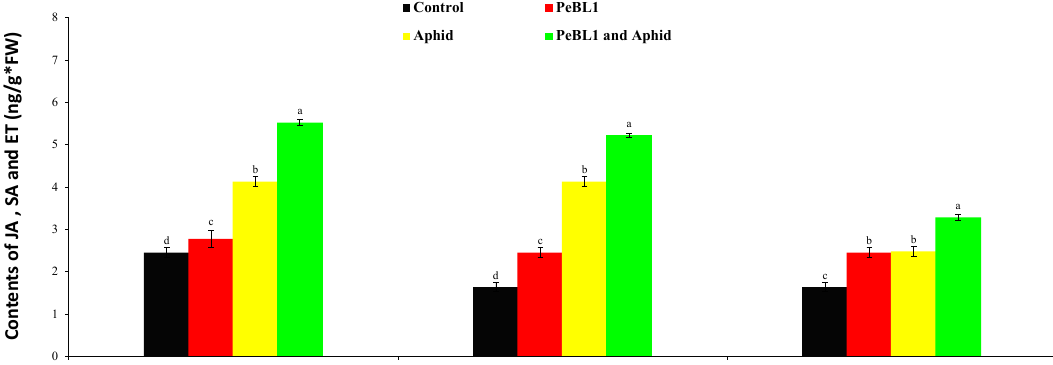
Figure 7. Jasmonic acid (JA), salicylic acid (SA), and ethylene (ET) contents in cucumber seedlings (mean ± SD). Treatment with PeBL1 was collected one day after spraying. In both treatments, the aphids were inoculated one day after seedlings were sprayed, and the samples were collected one day after inoculation. Data were compared statistically by the LSD, ANOVA, and Leven’s test using Statistix, version 8.1. Different lower-case letters show significant differences among various treatments performed in JA, SA, or ET ( p = 0.05).